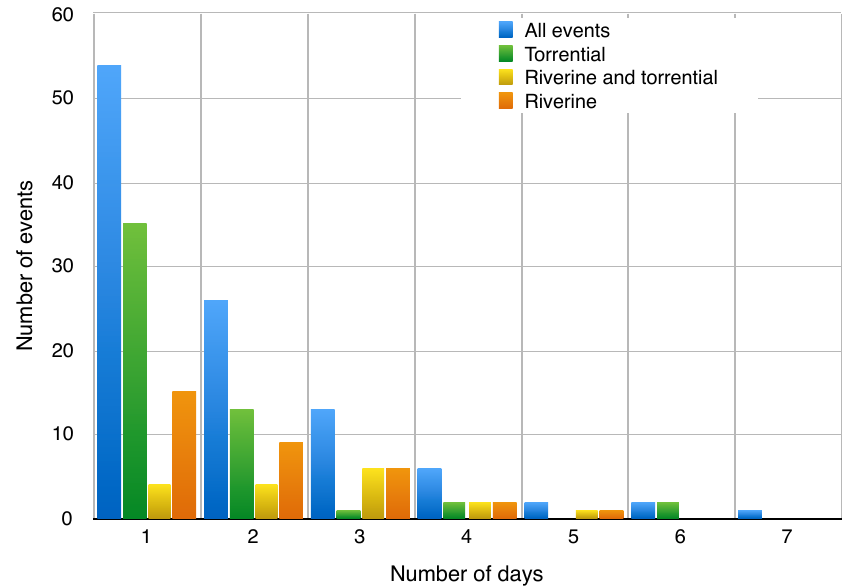
Figure 8. Distribution of the duration of Metropolitan events in days. The number of events ( y - Axis) is given as a function of the duration ( x -Axis) for events involving only torrents (green curve, 53 events in total) and only rivers (orange curve, 34 events), for multiscale events (yellow dotted curve, 17 events), and for all the events (blue dotted curve, 104